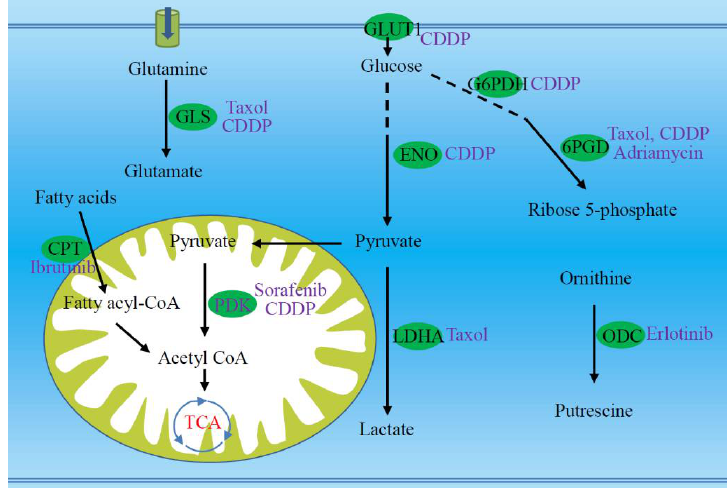
Figure 3. Targeting several key enzymes or proteins (green ellipses) are potential to re-sensitize the resistant tumor cells to chemotherapeutic agents (purple font). Targets marked with green ellipses involve multiple metabolic pathways, including glutaminolysis, transport and glycolysis of glucose, pentose phosphate pathway, fatty acid oxidation, pyruvate dehydrogenation, and production of polyamine. The drugs that can be metabolically regulated are highlighted with purple font. 6PGD, 6-phosphogluconate dehydrogenase; CDDP, cisplatin; CoA, coenzyme A; CPT, carnitine palmitoyltransferase; ENO, enolase; G6PDH, glucose-6-phosphate dehydrogenase; GLS, glutaminase; GLUT1, glucose transporter protein 1; LDHA, lactate dehydrogenase A; ODC, ornithine